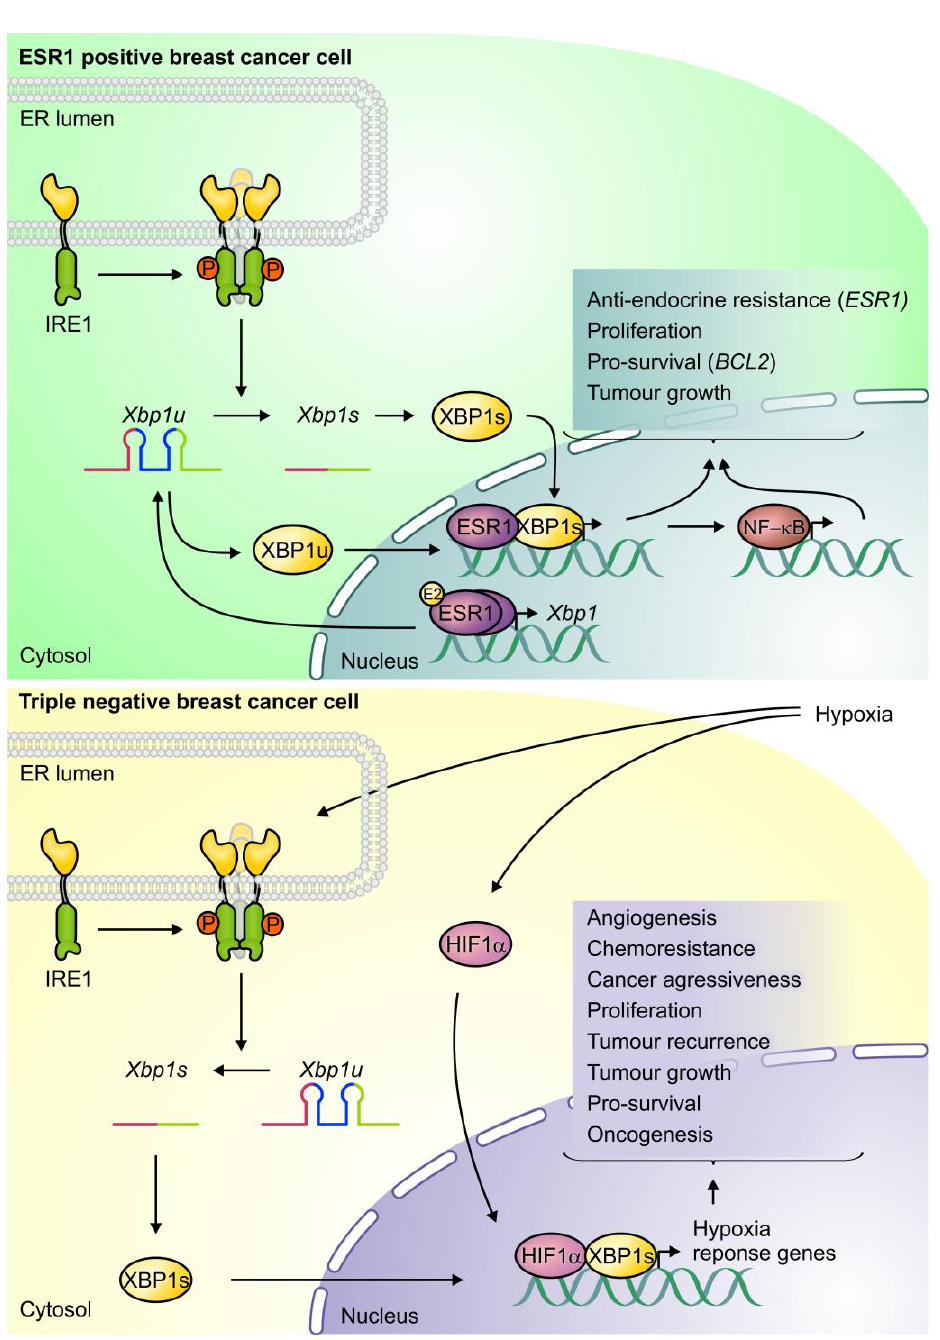
Figure 3. Dual roles of inositol-requiring enzyme 1 (IRE1)/ X-box binding protein 1 (XBP1) in estrogen receptor 1 (ESR1)+ breast cancers and triple negative breast cancer (TNBC). Both XBP1 isoforms can activate ESR1 signaling in ESR1+ breast cancer cells and facilitate estrogen (E2)-independent tumour forward mechanism. In TNBC cells, IRE1 exhibits high basal activity and activates XBP1s